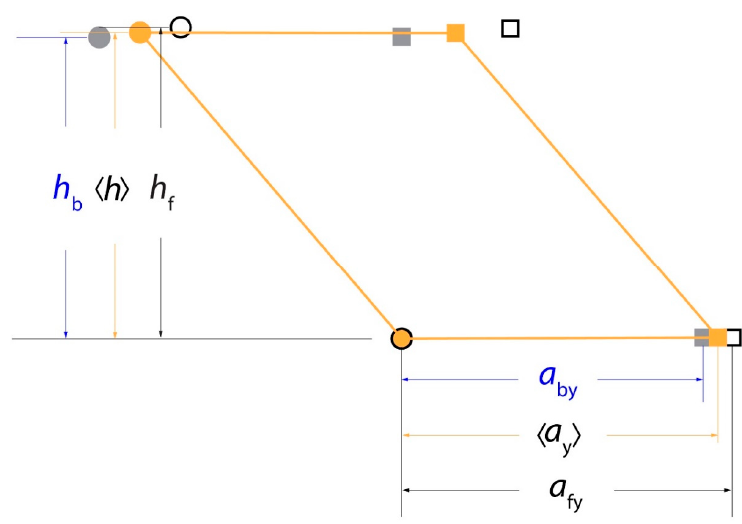
Figure 2. Definition of a 2D reference lattice (orange corners and orange edges) for strain calculation in an inclined interface. The circle and square patterns have the same meaning as those in Figure 1. Note the average step height < h > rather than the overlap (i.e., smaller) step height is adopted to build this reference